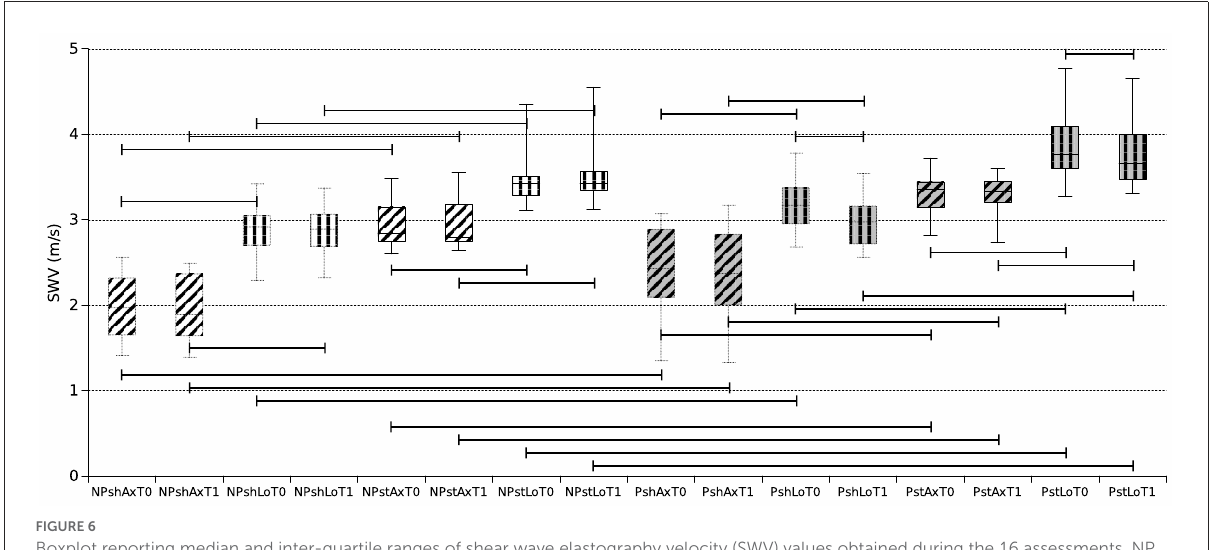
FIGURE6 Boxplot reporting median and inter-quartile ranges of shear wave elastography velocity (SWV) values obtained during the 16 assessments. NP, non-paretic limb (white background); P, paretic limb (gray background); sh, shortened muscle (dotted outline); st, stretched muscle (solid outline); Ax, axial probe position (horizontal stripes); Lo, longitudinal probe position (oblique stripes); T0 (left box), T1 (right plot). For example, NPshAxT0 represents the median SWV values among the selected unaffected (non-paretic) muscles of the 14 patients kept in a shortened position with the ultrasound probe in the axial position at T0. Horizontal bars indicate significant comparisons ( p <